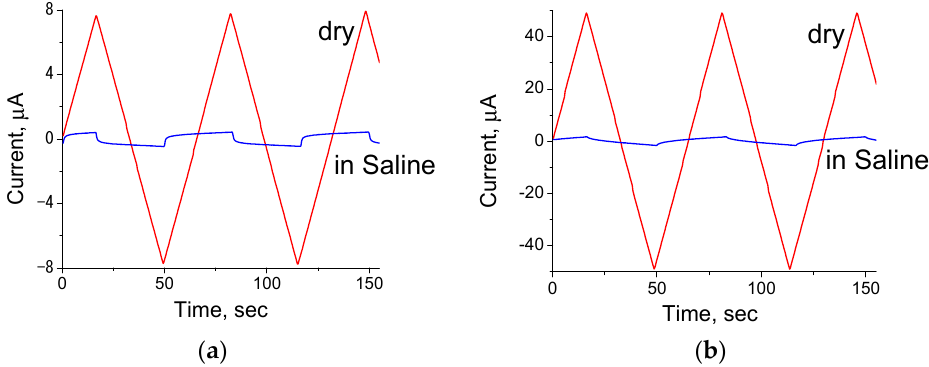
Figure 9. Current sweeps for the chitosan/SWCNT composite films measured in the dry state (red) and in physiological solution (blue). The SWCNT contents: 2.0 wt.% ( a ), 2.5 wt.% ( b ). The changes in the character of electric current in physiological solution are caused by the appearance of ionic charge carriers in the sample and the formation of a double